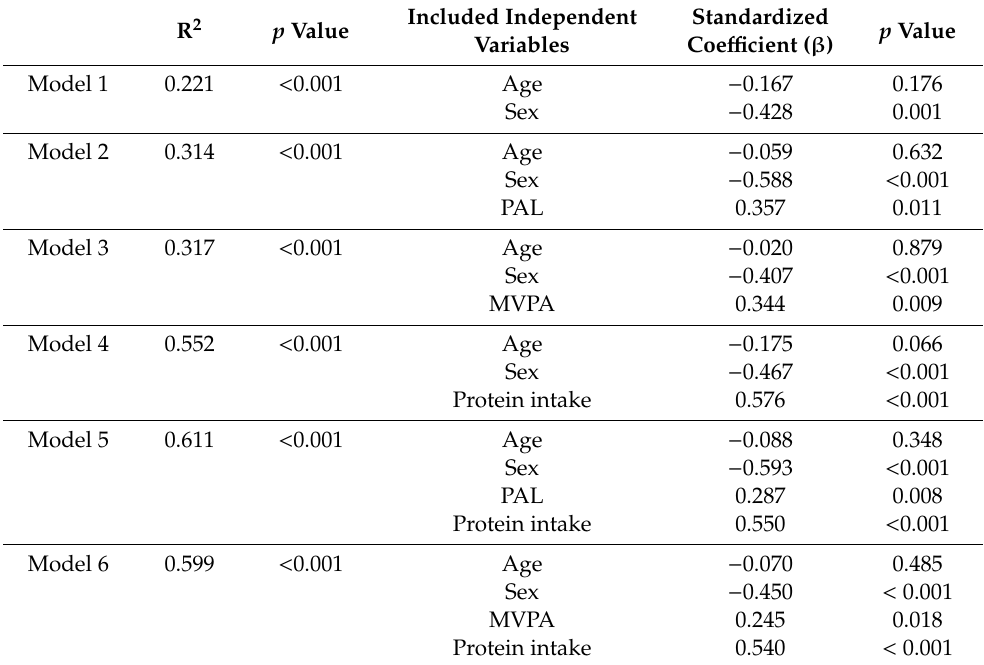
Table 3. Multiple linear regression analysis of the relationship of %FFM with PAL and protein intake. R 2 p